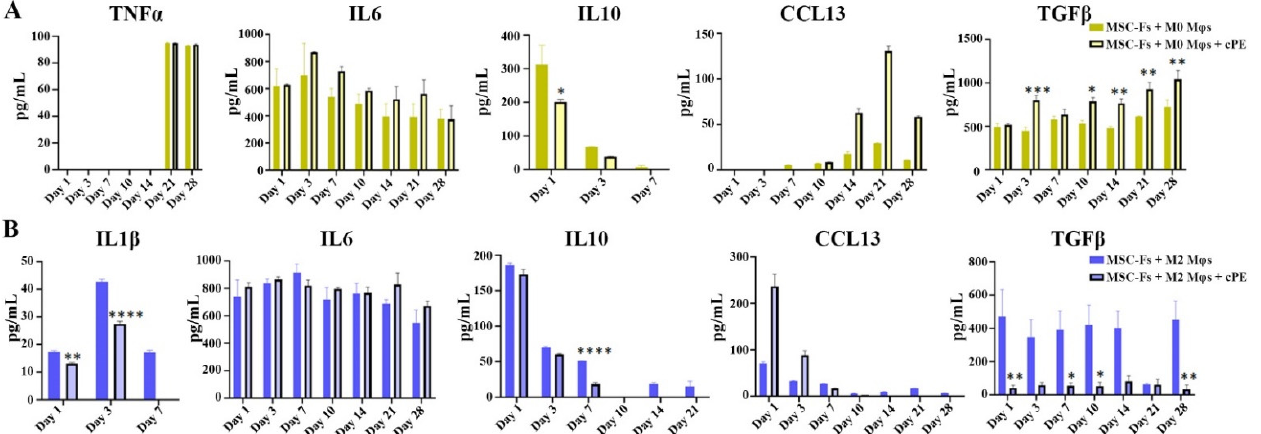
Figure 3. Concentration of cytokines in the perfusate from our fibroblast-M ϕ co-culture systems with or without the presence of cPE. ( A ) M0 co-culture system. ( B ) M2 co-culture system. (* p < 0.05, ** p < 0.01, *** p < 0.001, **** p < 0.0001) (values are ±SEM).